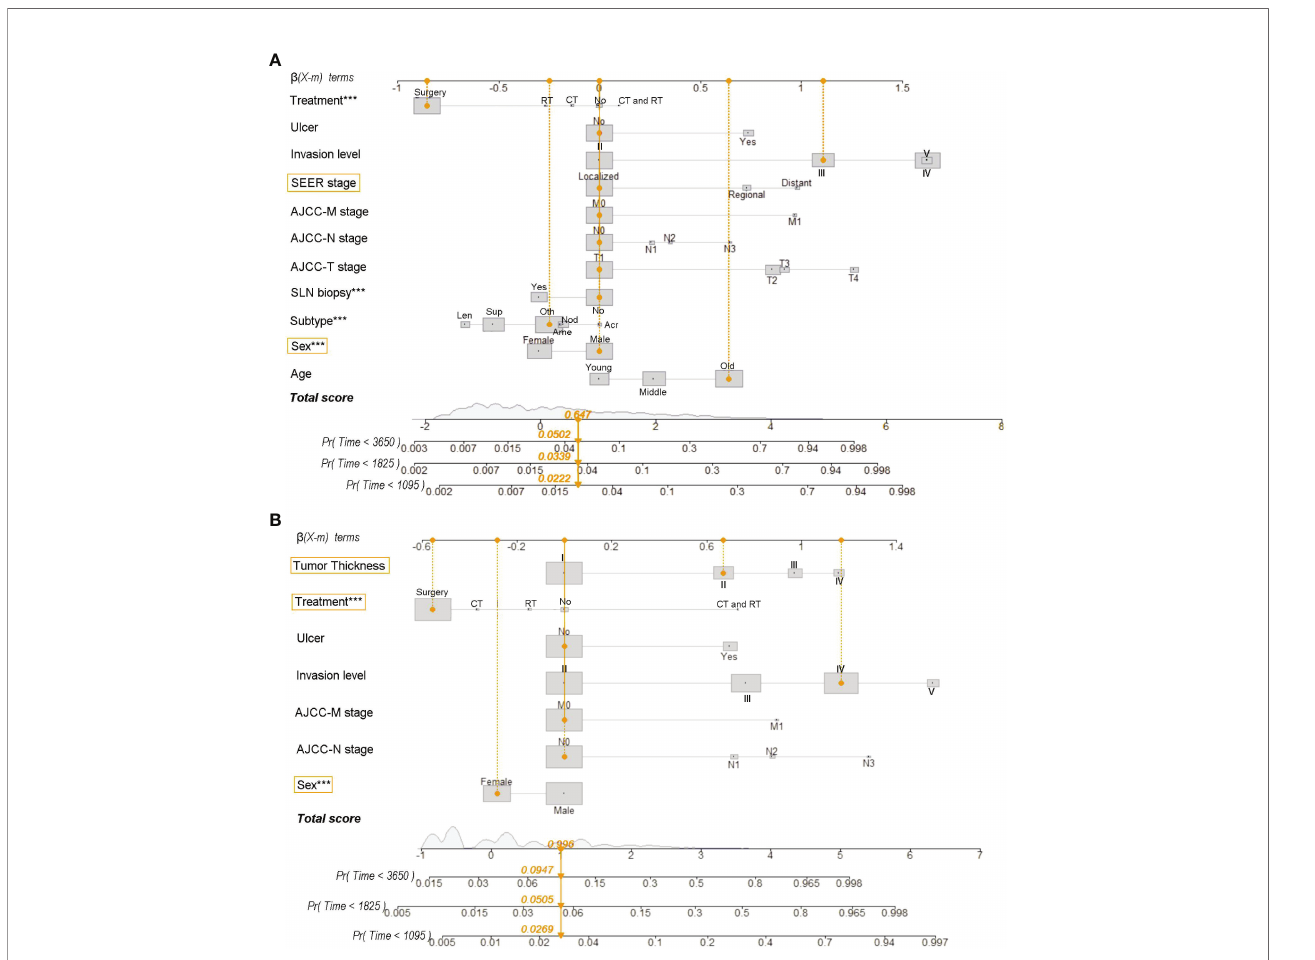
FIGURE 3 | Nomograms for predicting 3-, 5-, and 10-year probabilities of death resulting from CMM for patients with solitary CMM (A) and CMM with multiple tumors (B) . Treatment: No, No treatment; CT, chemotherapy (with/without surgery); RT, radiotherapy (with/without surgery); CT and RT, chemotherapy and radiotherapy (with/without surgery). Subtype (histological): Acr, Acral lentiginous CMM; Ame, Amelanotic CMM; Len, Lentigo CMM; Nod, Nodular CMM; Sup, Super fi cial spreading CMM; Oth, Other uncommon CMM. Tumor thickness: I, ≤ 100 mm; II, 100 – 200 mm; III, 200 – 400 mm; IV, >400 mm. Age: young ( ≤ 45 years), middle (45 – 60 years), and old (>60 years). Reg, regional; LN, lymph node; SLN, sentinel lymph node. ***Statistical signi fi cance was less